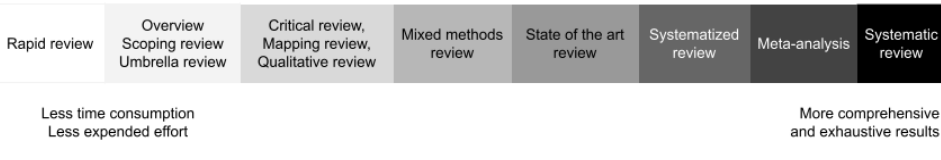
Figure 1. Comprehensiveness–exhaustiveness spectrum.